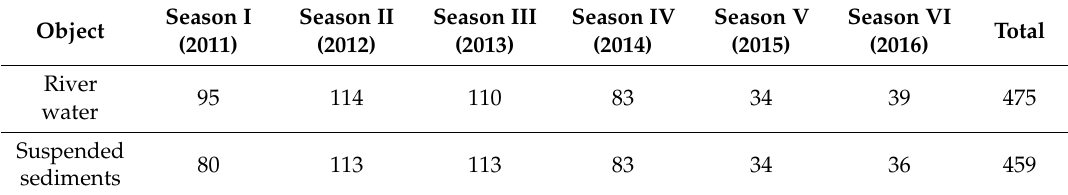
Table 1. Analytical database (number of samples for each field data